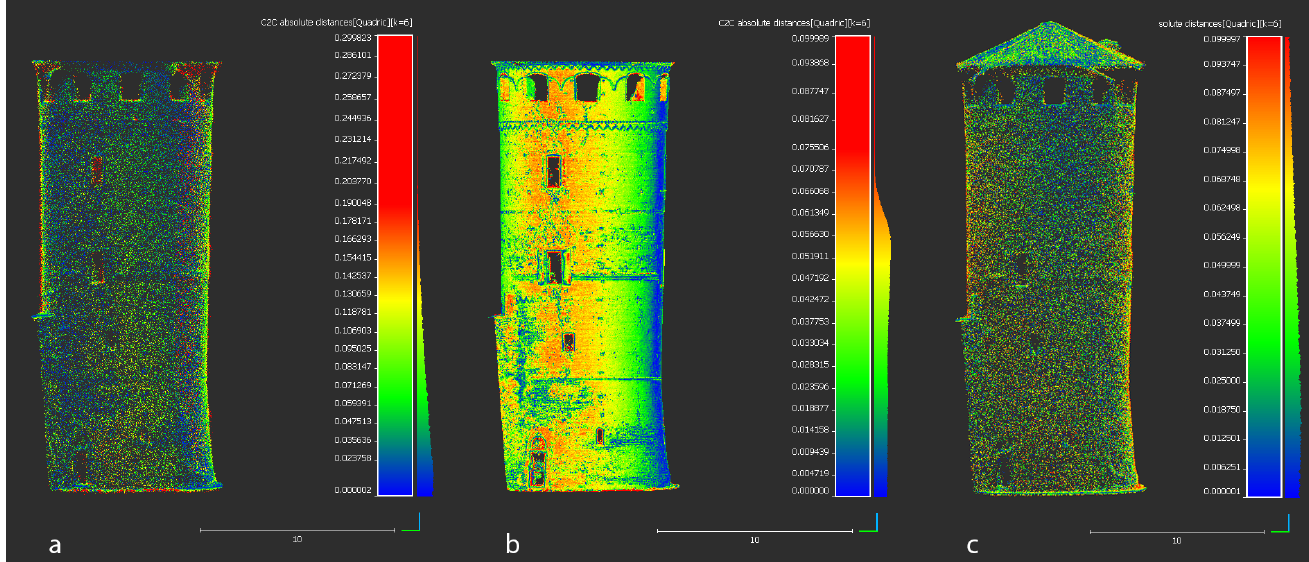
Figure 10. C2C analysis: ( a ) extracted L1 point clouds compared with SX10 data; ( b ) photogrammetric data compared with terrestrial data; ( c ) variance of P1 data compared with LiDAR L1.